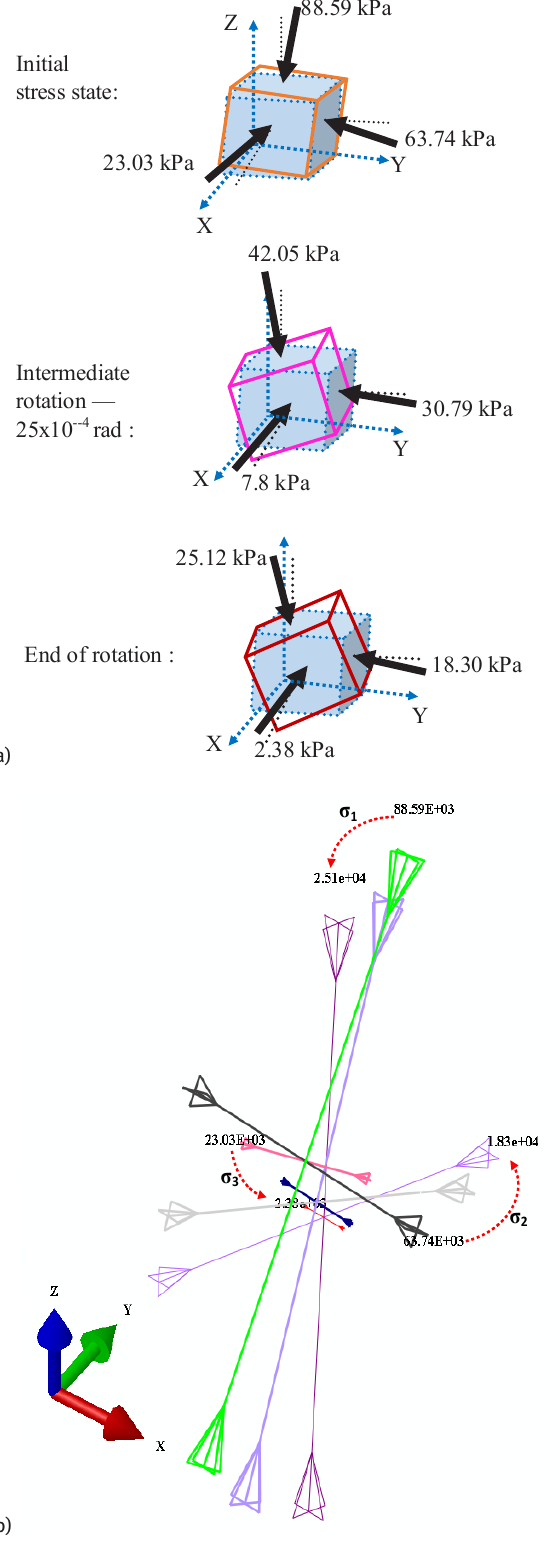
Figure 7: PSRs of element C: (a) 3D cubical element representation and (b) symbol plot for nine long-short pile composite foundation located at a distance 3 m away from the